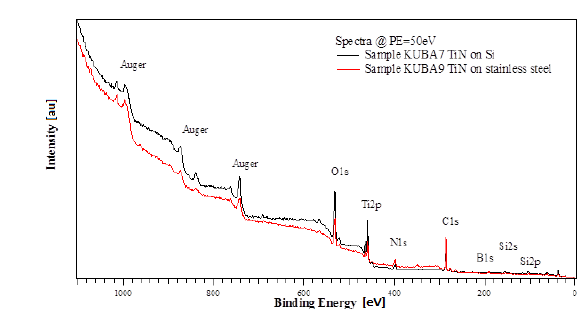
Figure 10. XPS spectra recorded with samples K7 and K9; PE = 50